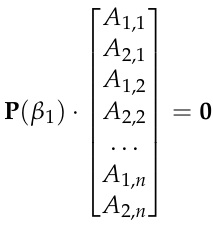
be consistent, as Equation (10) (the shear force at the top should be zero, S n φ ’ n (1) = 0).